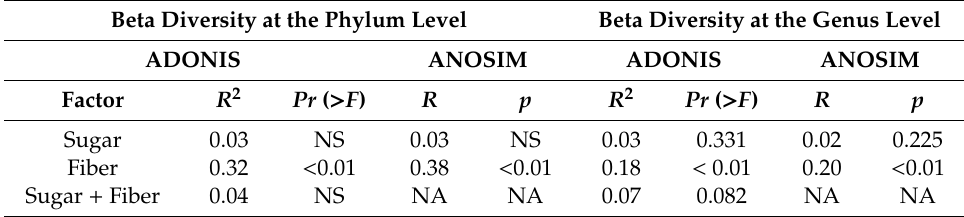
Table 1. ADONIS and ANOSIM analyses of beta diversity at the phylum and Genus levels. ANOSIM analysis revealed a significant change in Beta diversity at the phylum and genus levels for the fiber diet alone. ADONIS analysis also revealed that beta diversity was significantly impacted by the presence of fiber at both levels. NS, non-significant. NA, non-applicable. Beta Diversity at the Phylum Level Beta Diversity at the Genus Level ADONIS ANOSIM ADONIS ANOSIM Factor R 2 Pr ( > F ) R p R 2 Pr ( > F ) R